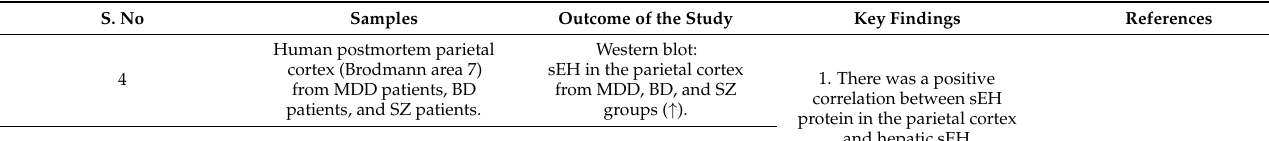
Human liver from MDD patients, BD patients, and SZ